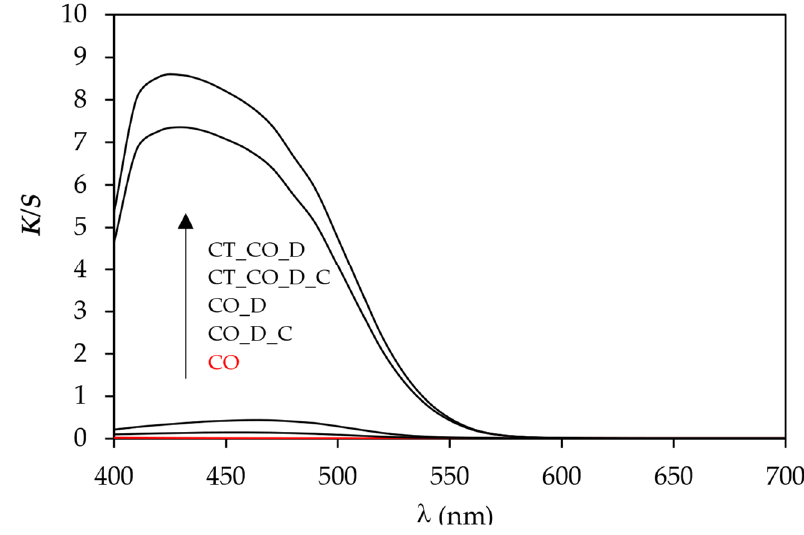
Figure 5. Values of K / S in dependence of the wavelength ( λ ) of samples CO, CO_D, CO_D_C, CT_CO_D and CT_CO_D_C.